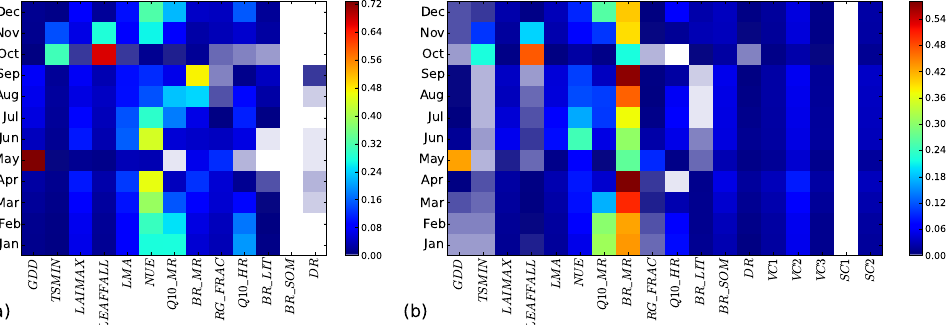
Figure 3. Matrices with total effect Sobol indices, S T , for monthly averages of NEE for (a) D ST and (b) D TR . The colormap changes from i red for large index values to blue for indices ≈ 1%. The grayscale corresponds to Sobol index values from 1% down to 0 . 1%, while blank cells indicate values smaller the 0 . 1%.